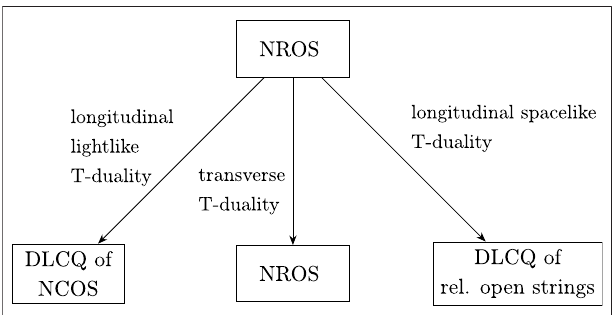
FIGURE 3 | T-duality relations for NR open string theory (NROS). The transverse T-duality swaps Dirichlet and Neumann boundary conditions in the usual